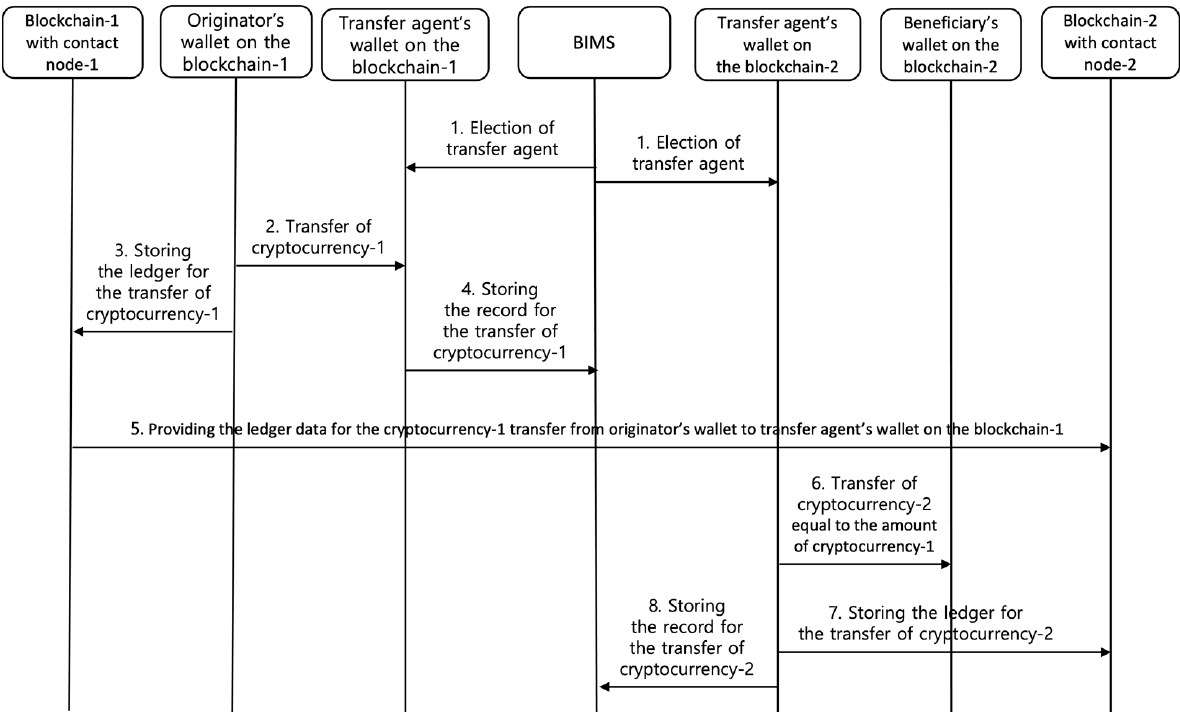
Figure 6. The service scenario for the transfer between the cryptocurrency-1 and cryptocurrency-2.